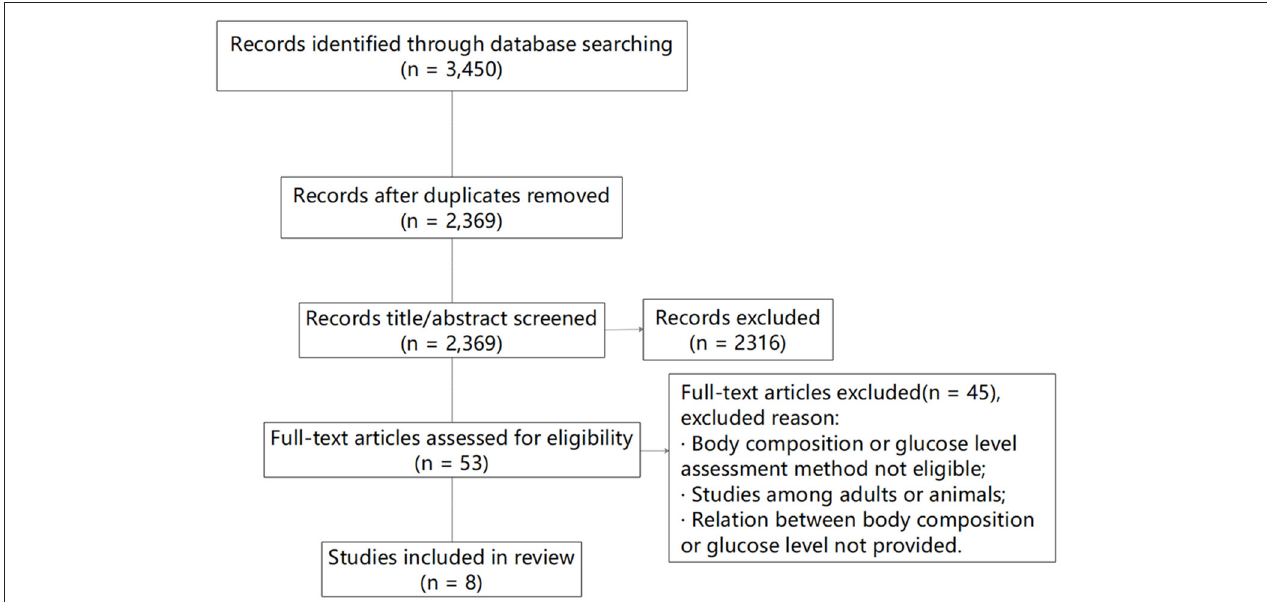
FIGURE 1 | Flow diagram of the literature search and paper selection